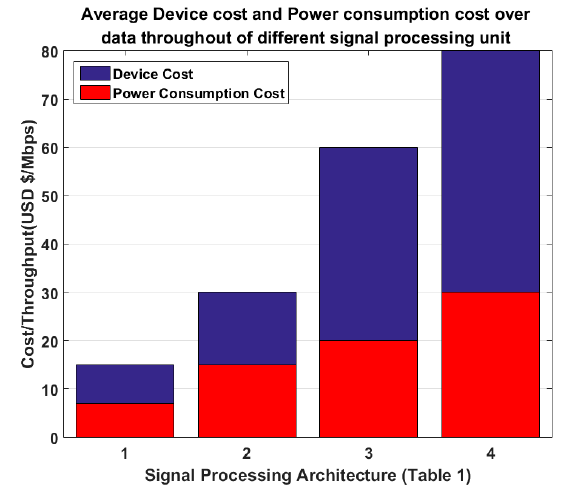
Figure 6. Simulated average device cost and power consumption cost over data throughput for different SPUs (Table 2).